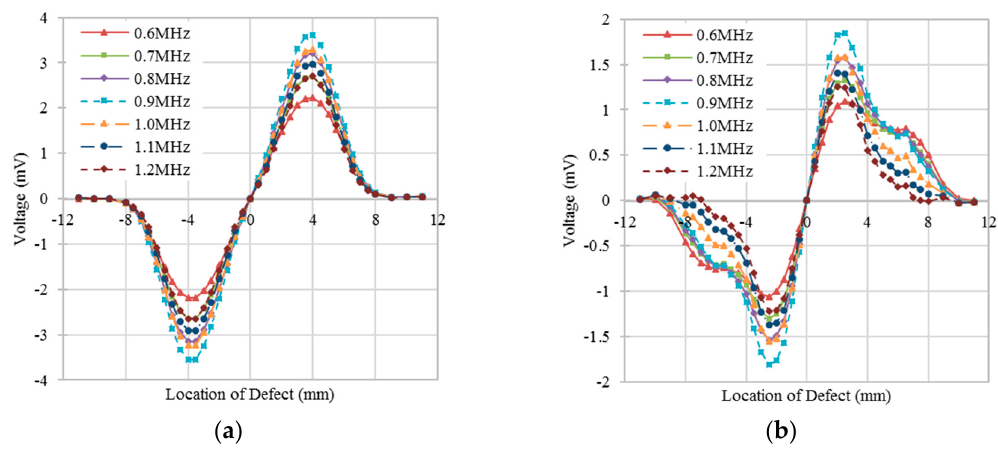
Figure 5. Output voltage of a differential sensing pair with the position sweep of defects at different excitation frequencies. ( a ) Transverse defect with 0.5 mm in depth; ( b ) Longitudinal defect with 0.5 mm in depth.